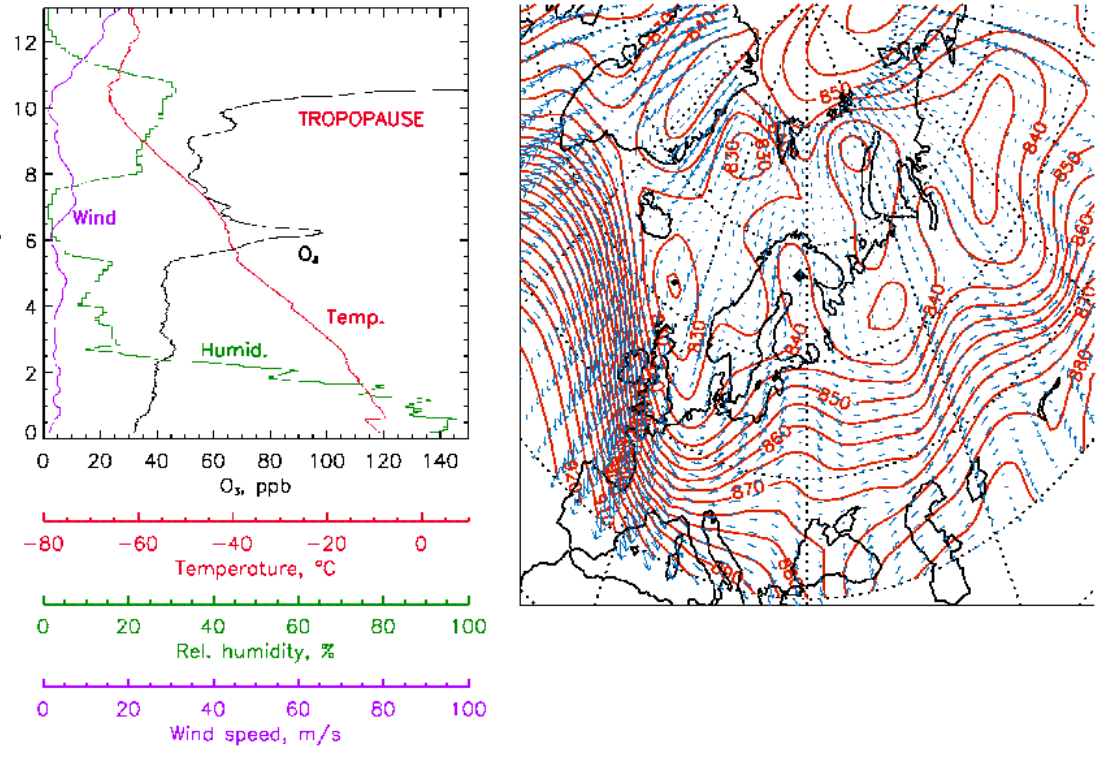
Fig. 3. Same as in Fig. 1 but at 12:00UTC on 16 February 2000.